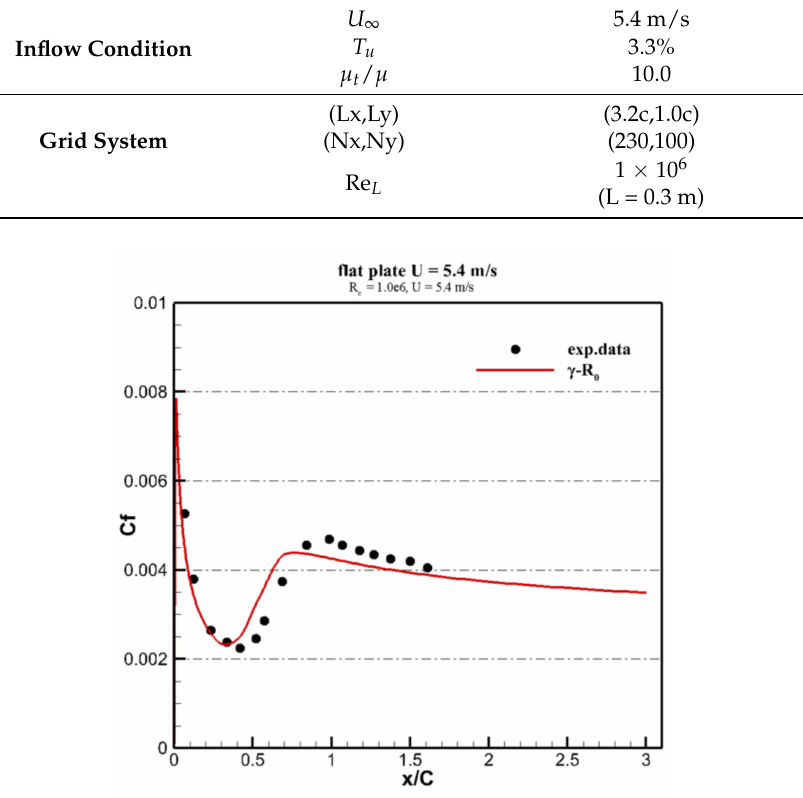
Figure 2. Skin friction coefficient distribution with the original formulation over the flat